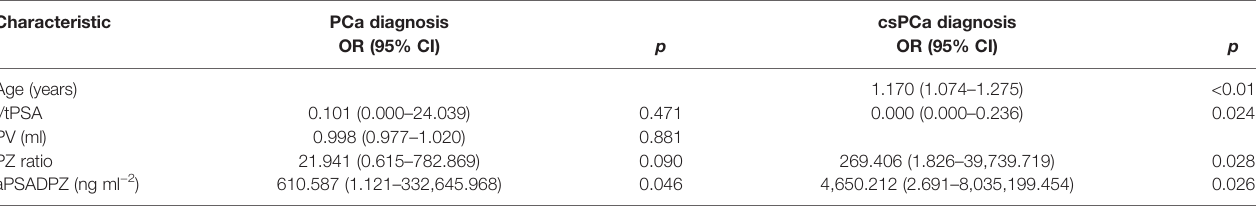
TABLE 3 | Multivariate regression analyses for various parameters to detect PCa and csPCa in biopsy-naïve men with PIRADS v2 categories 3. Characteristic